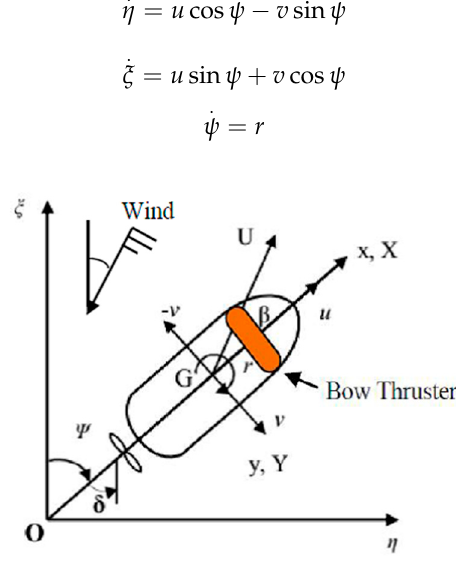
Figure 2. Ship dynamic in Cartesian reference frame.